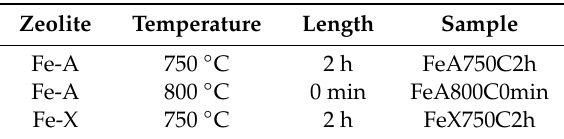
Table 1. Parent Fe-exchanged zeolite, temperature, length of the reduction treatment, and name of the obtained